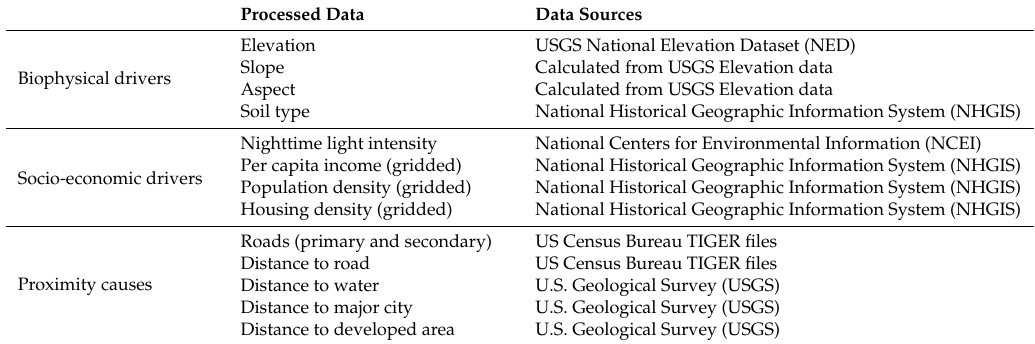
Table 1. Explanatory drivers and their data